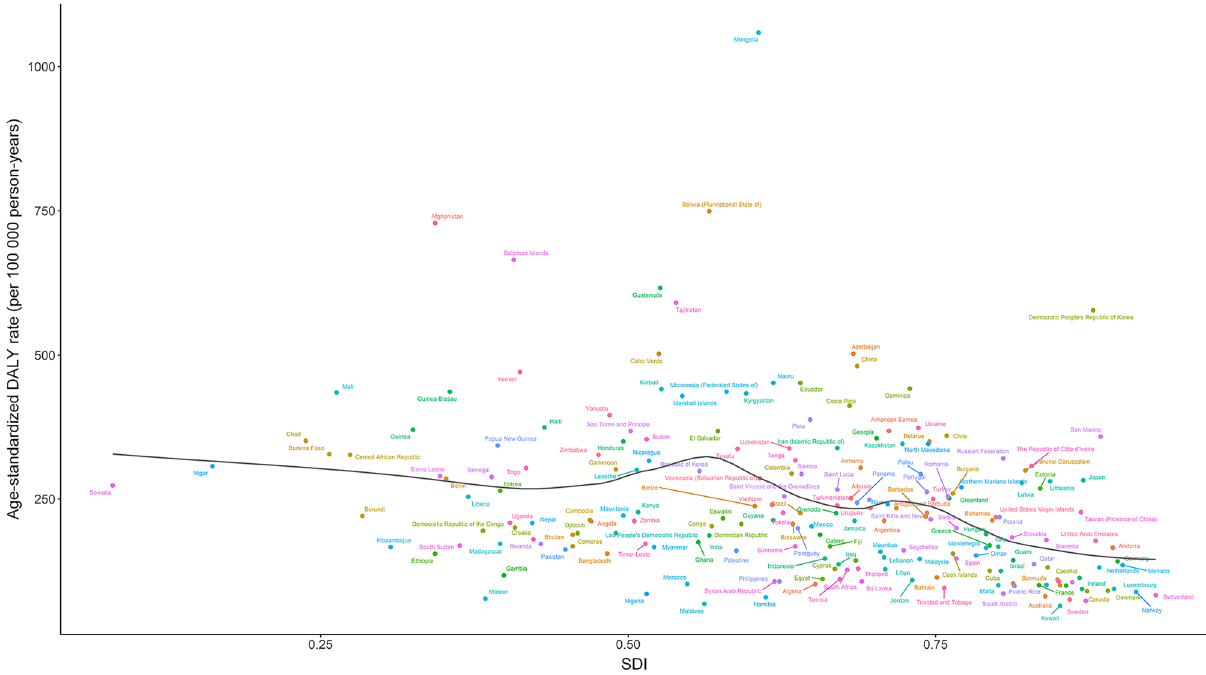
Figure 6. Age-standardized DALY rates for stomach cancer for 204 countries and territories by SDI, 2019. Black line represents the expected age-standardized DALY rates of stomach cancer based solely on SDI. For each region, points from the left to right depict estimates from each year from 1990 to 2019. SDI Socio-demographic Index, DALY disability adjusted life